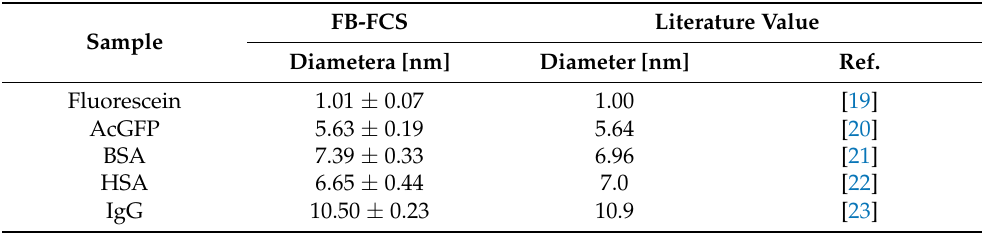
Table 1. Measurement Results of Various Samples. The diameter of FB-FCS shows mean ± standard error ( n = 5–8).